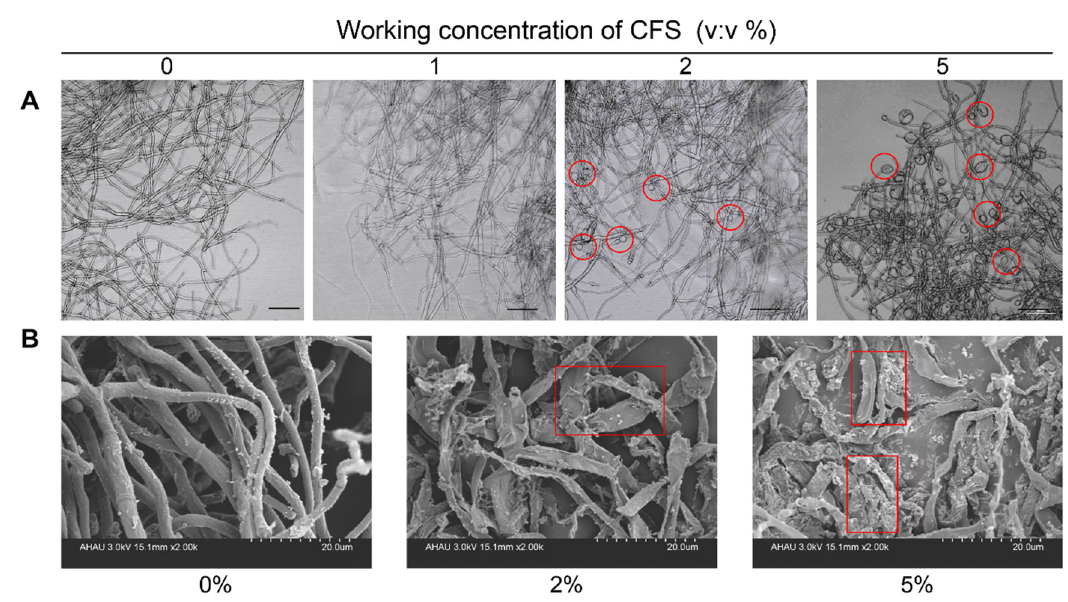
Figure 2. Effects of CFS on the morphological structure of B. dothidea . ( A ) Effects of CFS on the morphological structure of B. dothidea were tested in a PDB medium containing the indicated concen- tration of CFS. The hyphae were collected after 24 h of treatment, and images were recorded using a microscope. Black bars represent 50 µm. Hyphae swollen into spheres are marked by red circles. ( B ) Scanning electron micrographs of B. dothidea treated with CFS at different working concentrations. The shriveled hyphae are marked by red rectangles.